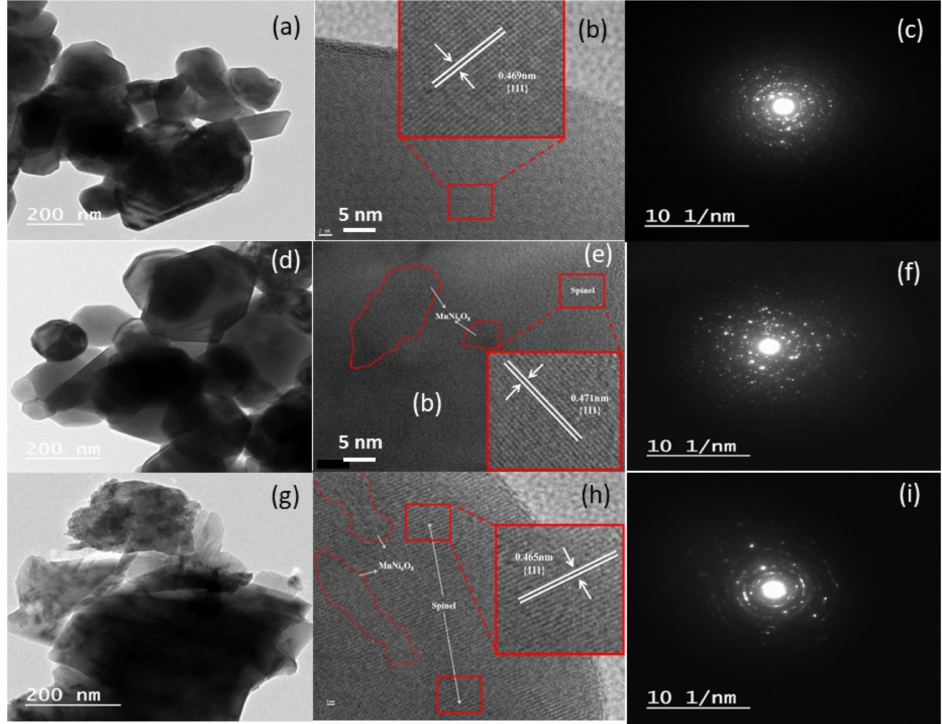
Figure 4. HRTEM images and SAED patterns of LiMn 2 O 4 ( a – c ), LiNi 0.5 Mn 1.5 O 4 ( d – f ) and LiNiMnO 4 @Ni 6 MnO 8 ( g – i ) powders synthesized by sol-gel method. Insets show fringes from selected well-crystallized